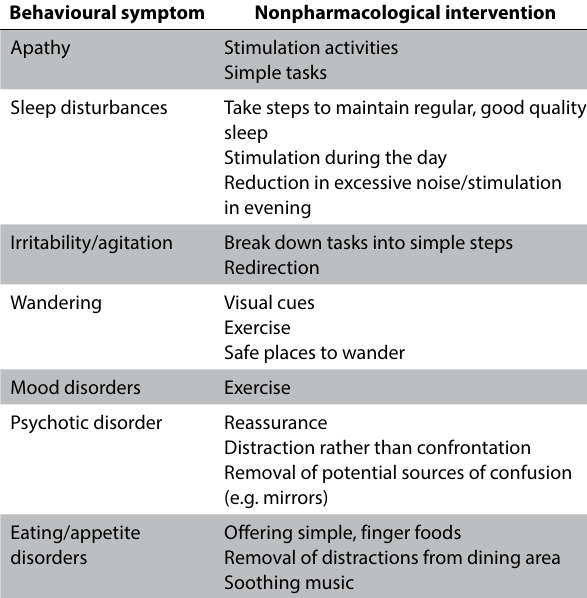
Table VI. Nonpharmacological approaches to manage behavioural symptoms and mood disorders in patients with AD